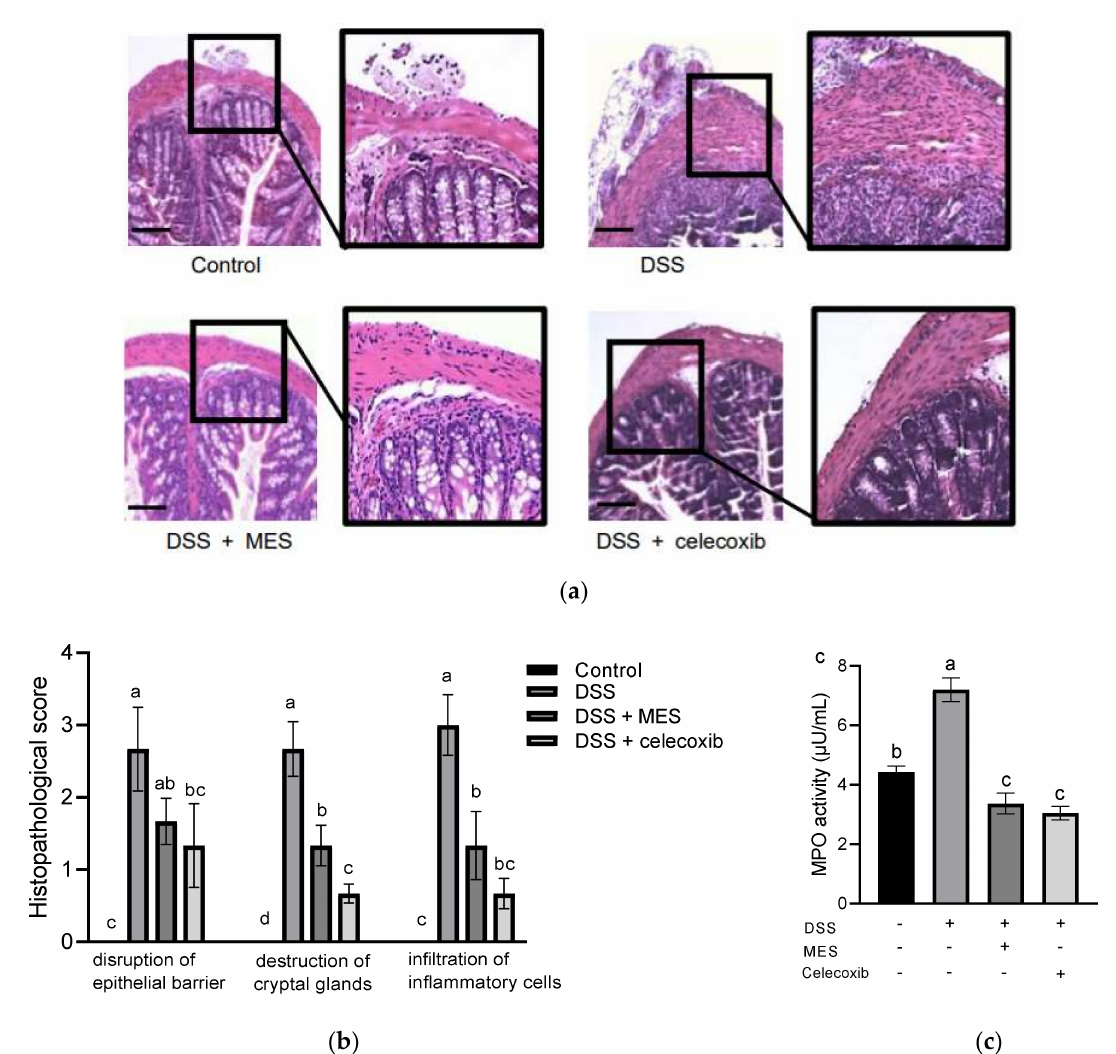
Figure 3. MES supplementation ameliorates DSS-induced tissue damage. ( a ) Hematoxylin and eosin (H & E) images (magnification, × 100 left), scale bar = 100 µ m. ( b ) Histological scores. ( c ) Myeloperox- idase (MPO) activity of the colon tissues. All data are expressed as mean ± SD. Bars with no common letters are significantly different ( p < 0.05). DSS: dextran sulfate sodium; MES: meroterpenoid-rich ethanoic extract of a brown algae, Sargassum macrocarpum